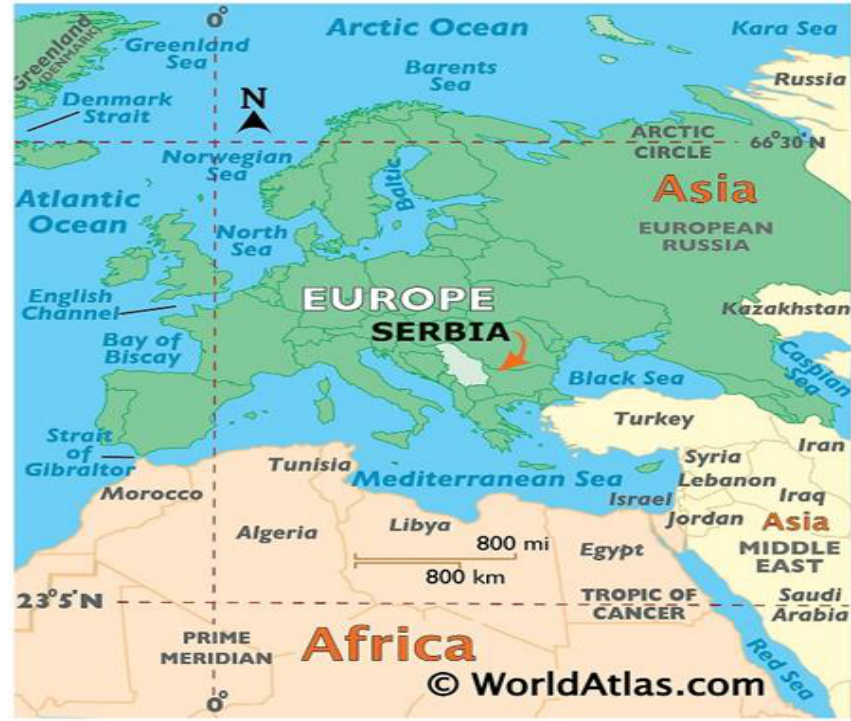
Figure 2. Position of Serbia in Europe .